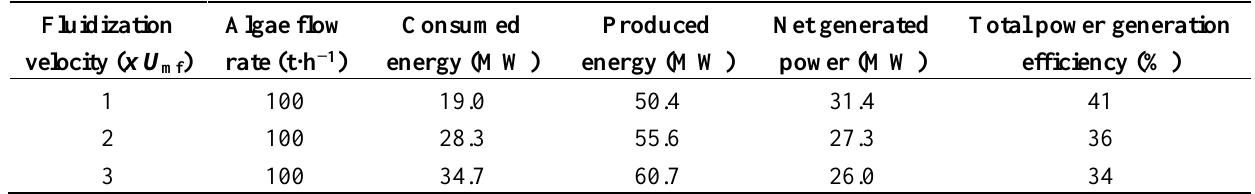
Table 5. Detailed consumed energy and produced energy in the proposed integrated-processes. Fluidization